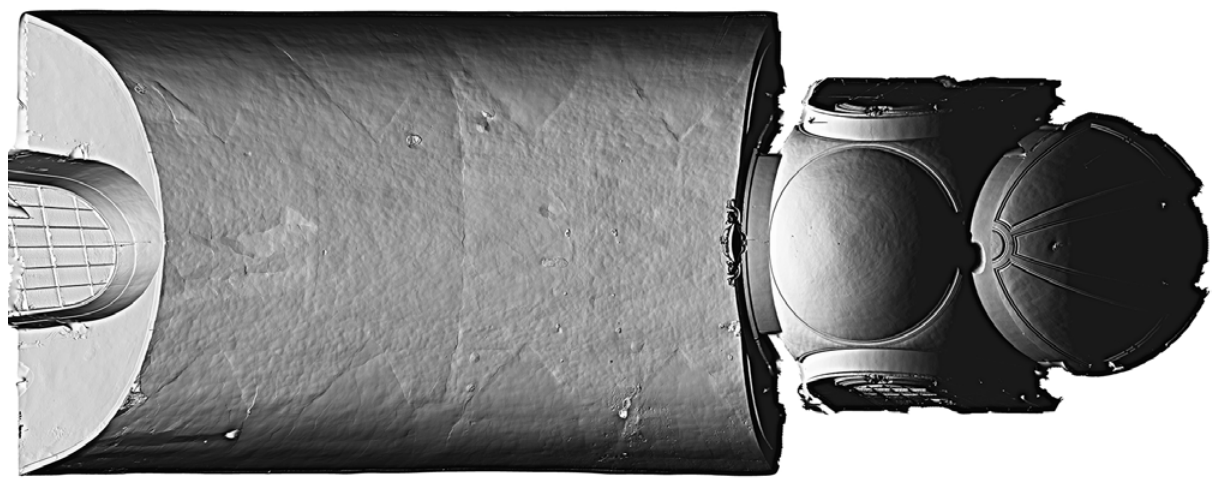
Figure 1. Mesh model of the vault of San Carlo dei Barnabiti showing the infilled